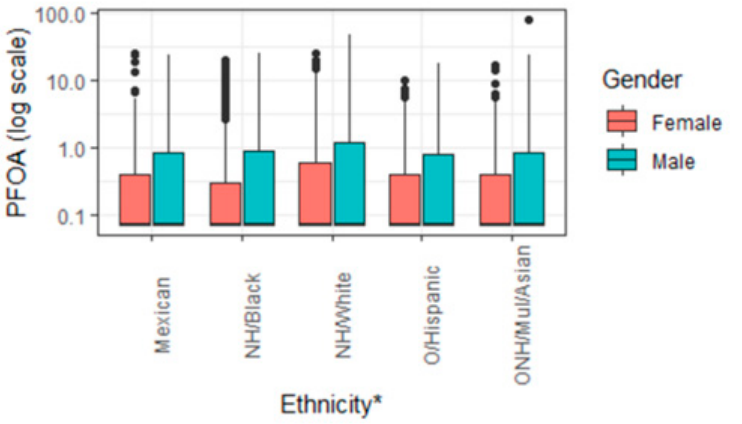
Figure 2. Distribution of PFOA by ethnicity and gender. * Note: Mexican American = Mexican, other Hispanic = O/Hispanic, non-Hispanic White = NH/White, non-Hispanic Black = NH/Black, other non-Hispanic race including non-Hispanic multiracial and Asian = ONH/Mul/Asian.